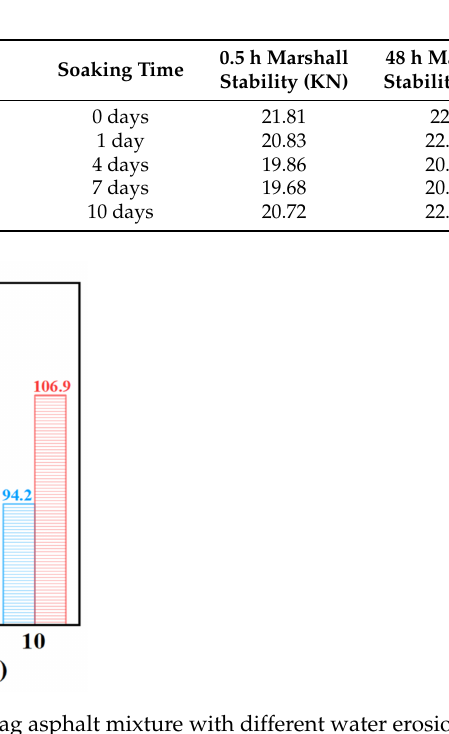
Table 9. Test results of stability.